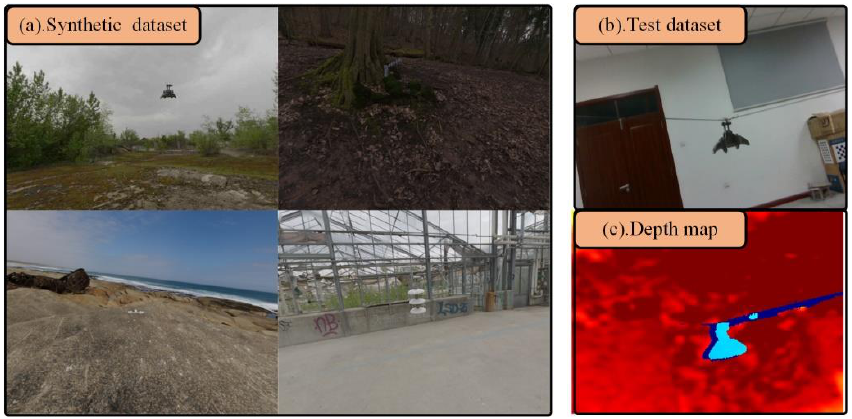
Figure 13. Example of the dataset. ( a ) Synthetic dataset; ( b ) test dataset; ( c ) depth map.